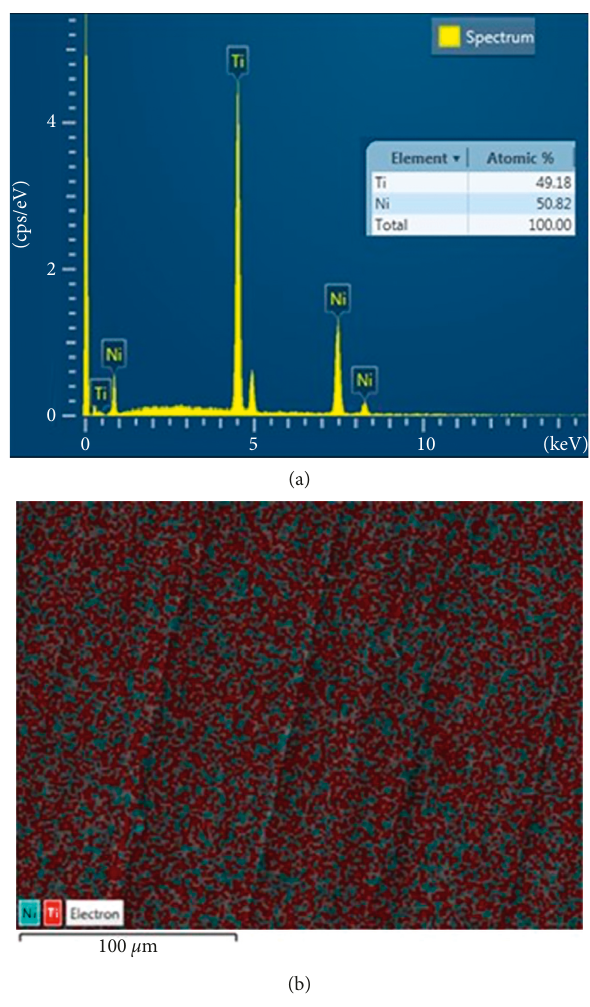
Figure 8: EDS results of the NiTinol coating sprayed with the HVOF technique: (a) EDS spectrum and (b) EDS-layered image.